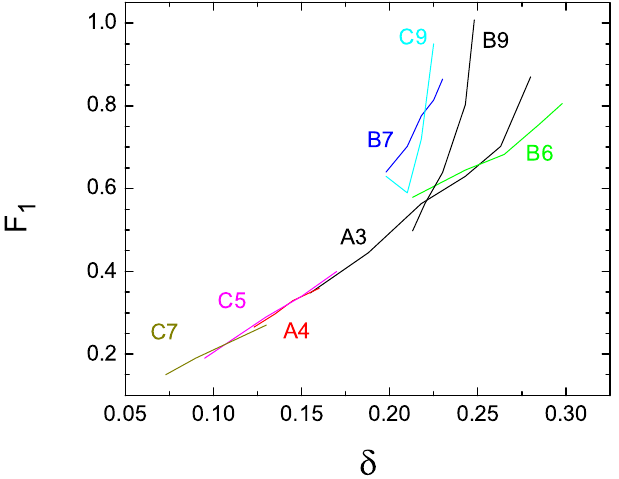
FIG. 20. (Color) Scaled beta function as a function of scaled acceptance for example lattices for the second passband centered at 200 MeV =c